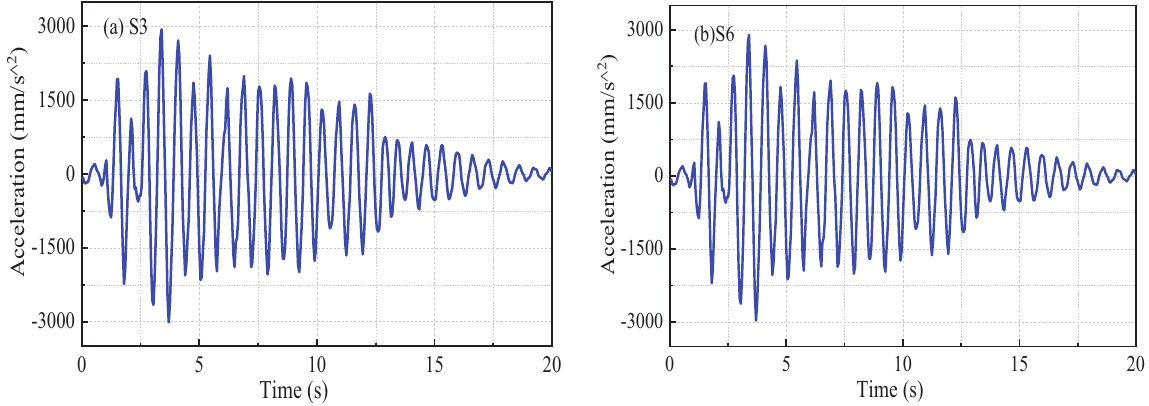
Fig. 5. Acceleration test value of measurement point under 0.22g EL-Centro wave (a) S3; (b) S6.